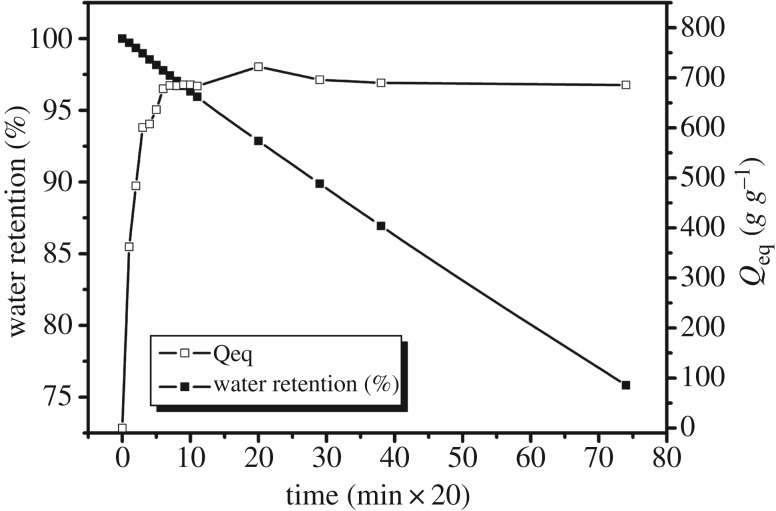
Water absorbency (white squares) and water retention (black squares) of SAPs.